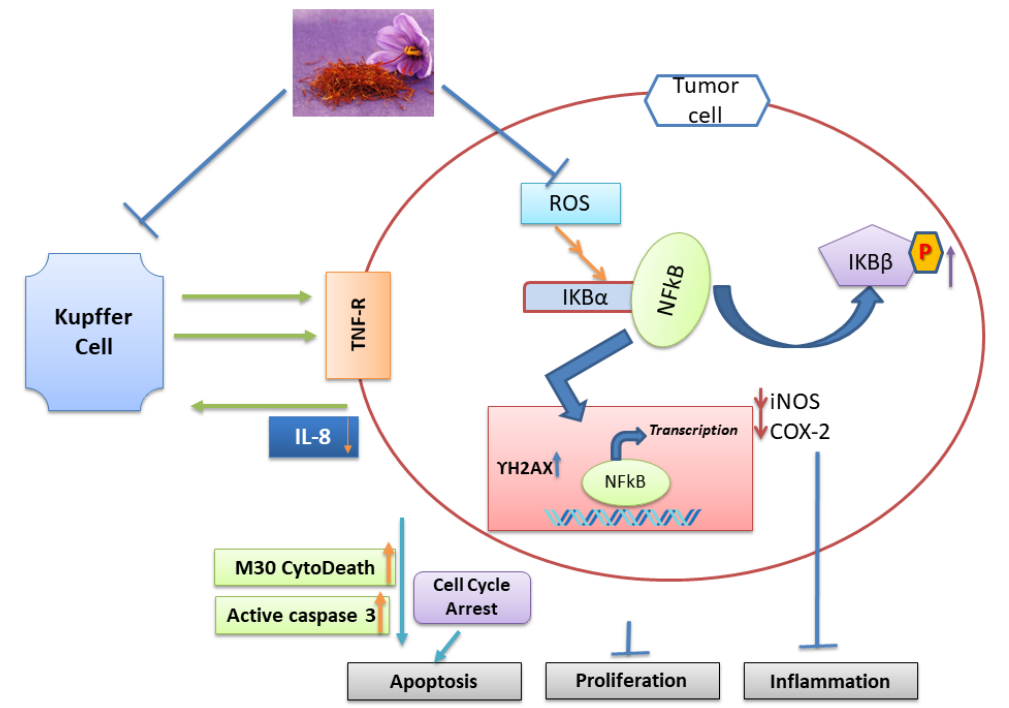
Figure 3. Apoptosis, inflammation, and proliferation alteration by Sa ff ron in liver cells. Both cell lines and animal model data indicate that TNF α receptor alters in Kupper cells. This results in suppression of NF- κ B signaling via suppressing the level of iNOS, COX-2, and IL-8. Cell cycle arrest caused by sa ff ron via caspases activation (Figure modified from Amin et al., 2011